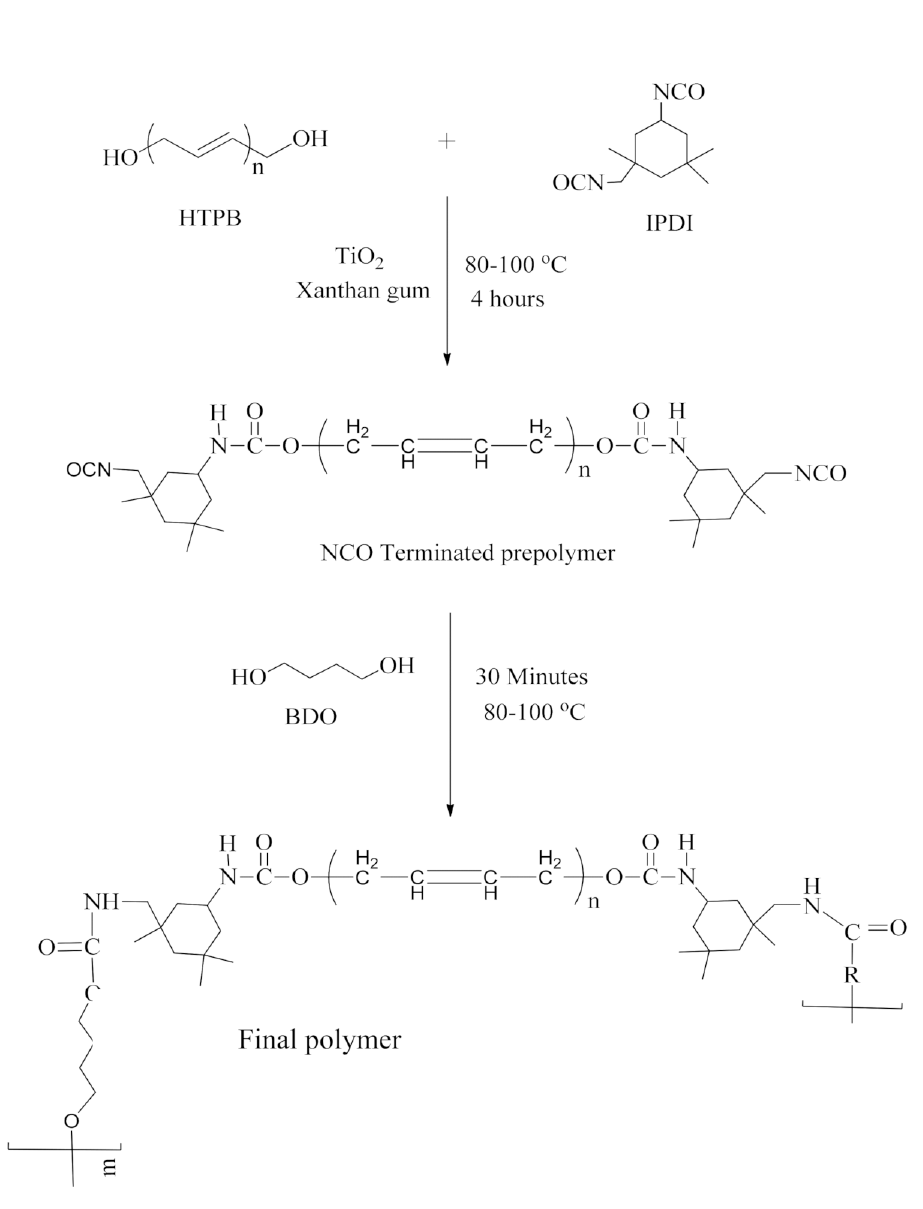
Figure 1. Synthesis of